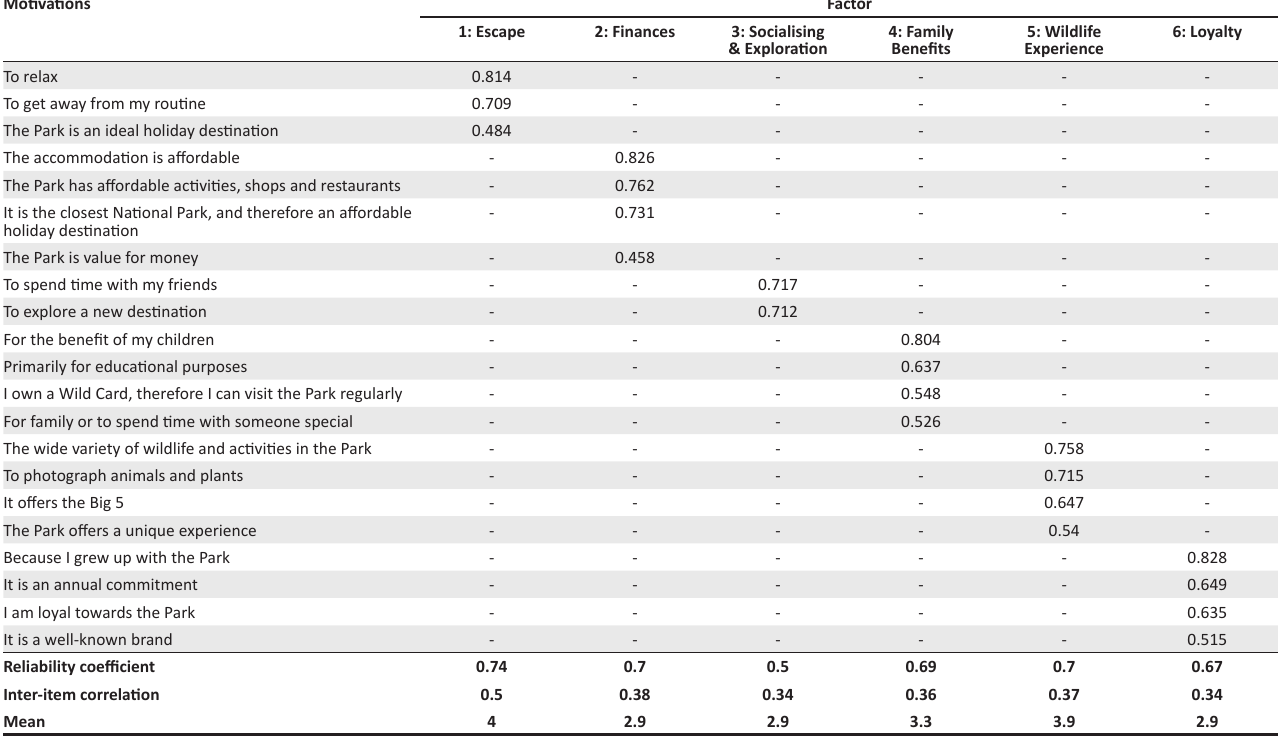
TABLE 3: Factor analysis results of visitors’ motivations to the Kruger National Park.